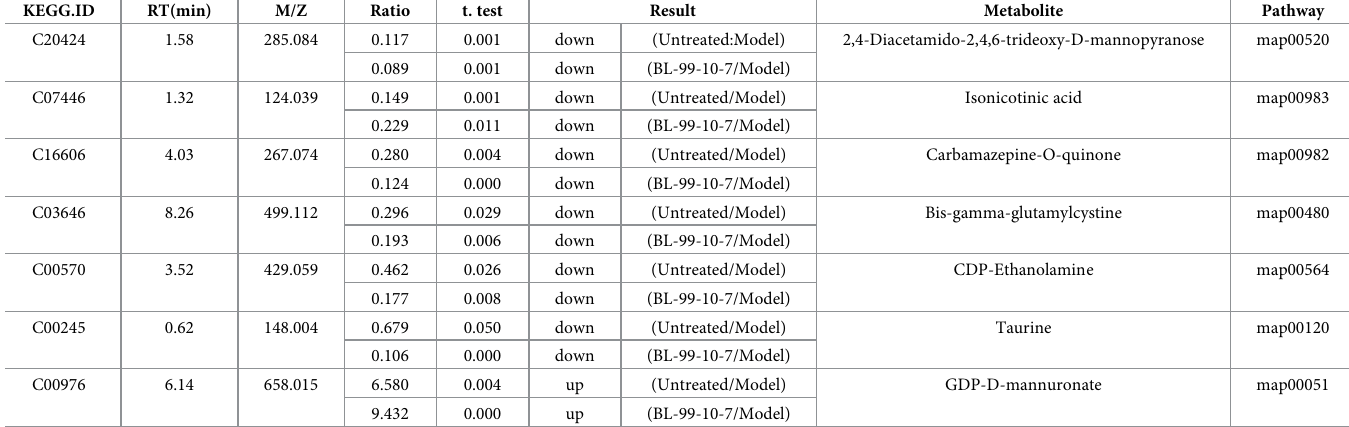
Table 2. Positive-ion metabolites in the intestinal function disorder zebrafish after B . lactis BL-99 treatment.